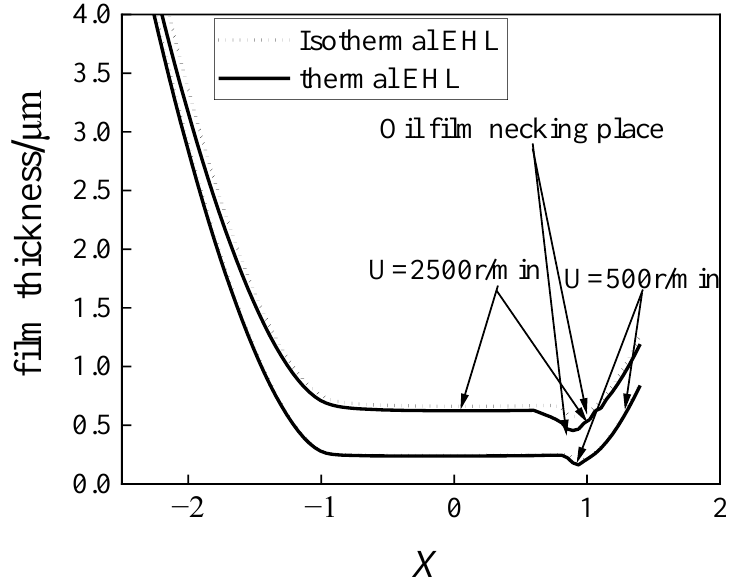
Figure 5. Influence of velocity parameters on thermal EHL.